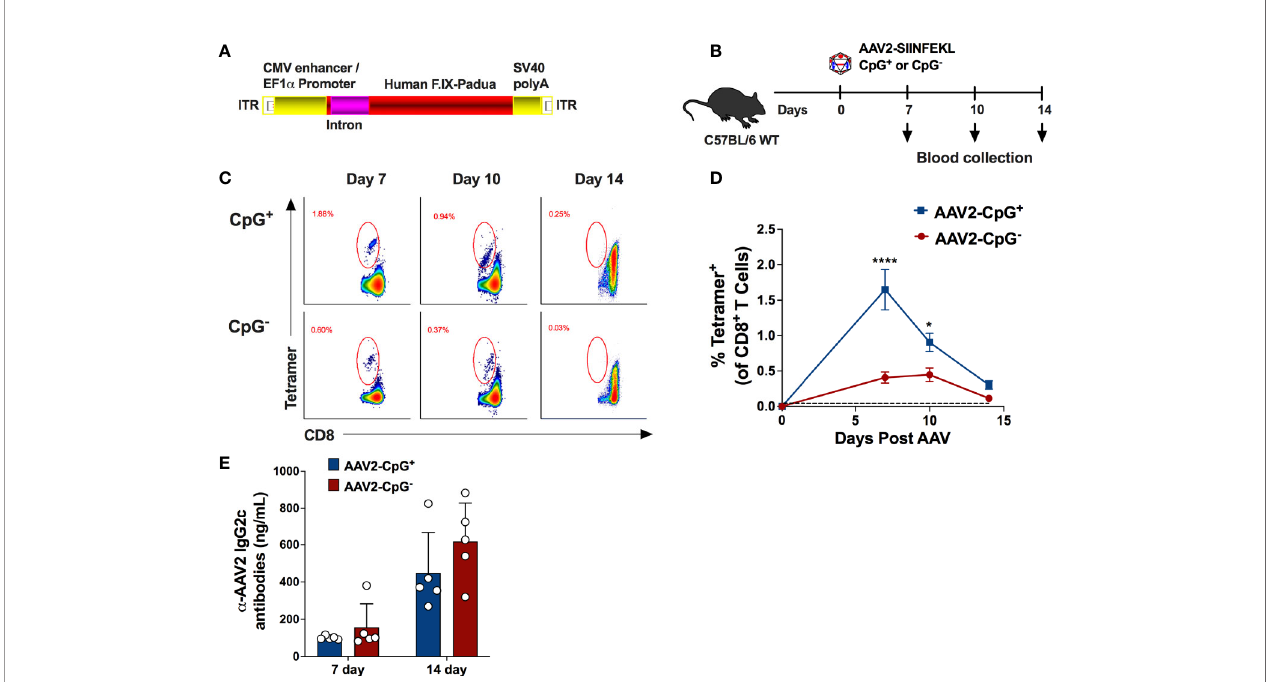
FIGURE 2 | Absence of CpG motifs signi fi cantly reduce the percentage of AAV capsid speci fi c CD8 + T cells but does not impact capsid-speci fi c antibody formation. (A) Schematic representation of CpG-free expression cassette encoding hFIX with padua mutation. This cassette was packaged into AAV2-SIINFEKL capsid. (B) Experimental timeline of WT C57BL/6 mice injected with either AAV2-SIINFEKL-CpG + or AAV2-SIINFEKL-CpG − vector. (C) Representative fl ow plots showing AAV capsid-speci fi c CD8 + T cells at different time points in mice injected with AAV2-SIINFEKL-CpG + and AAV2-SIINFEKL-CpG − vector. (D) Percentages of capsid speci fi c CD8 + T cell in mice injected with AAV2-SIINFEKL-CpG + and AAV2-SIINFEKL-CpG − vector. The dotted line at 0.045% represents the limit of detection of capsid speci fi c CD8 + T cells using the tetramer. (E) Anti-AAV2 IgG2c antibody titers in plasma samples from mice injected with AAV2-SIINFEKL-CpG + or AAV2- SIINFEKL-CpG − vector. Samples were collected at days 14 and 28 post vector injection. Data are average ± SEM of at least fi ve animals per group. Each circle represents an individual animal. Statistically signi fi cant differences are indicated. *P < 0.05, ****P <